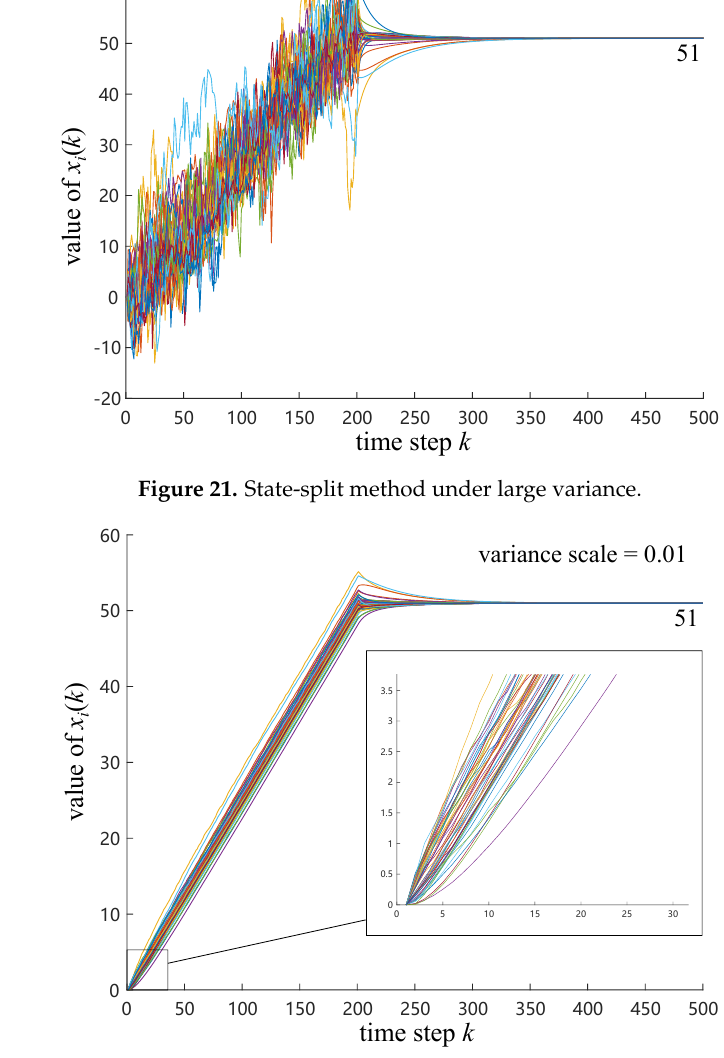
Figure 22. State-split method under small